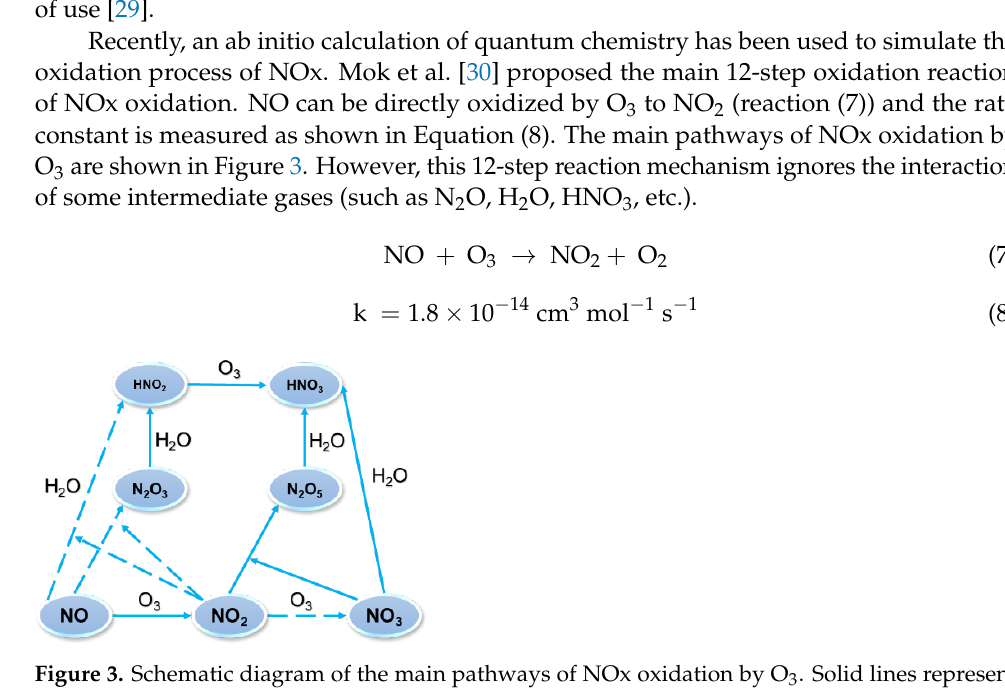
Figure 2. Possible pathways of NO oxidation with the Mars – van Krevelen mechanism occurring on Mn 5c site and lattice O on MnO 2 . The red pathway represented the favoured mechanism of NO oxidation on MnO 2 . Modified from [26] with permission from the American Chemical Society.